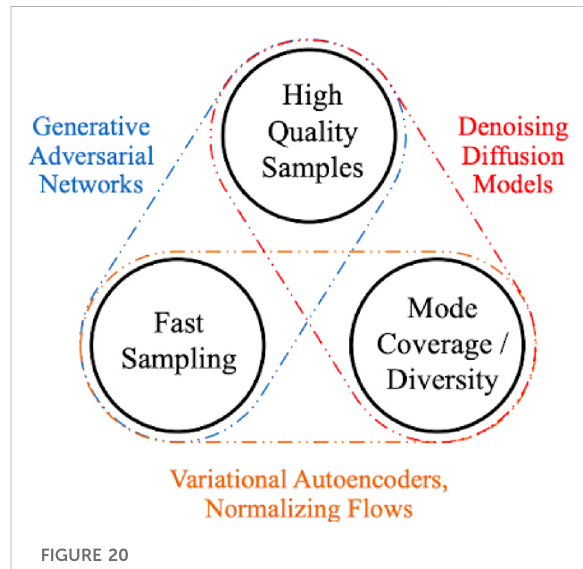
FIGURE 20 Generative learning trilemma (Vahdat and Kreis,